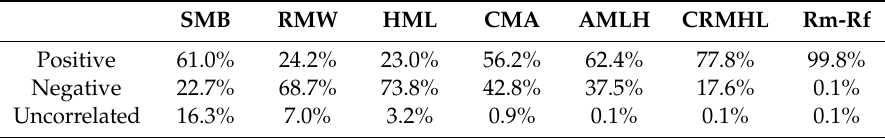
Table 3. Correlations between seven factors and excess return of stocks.